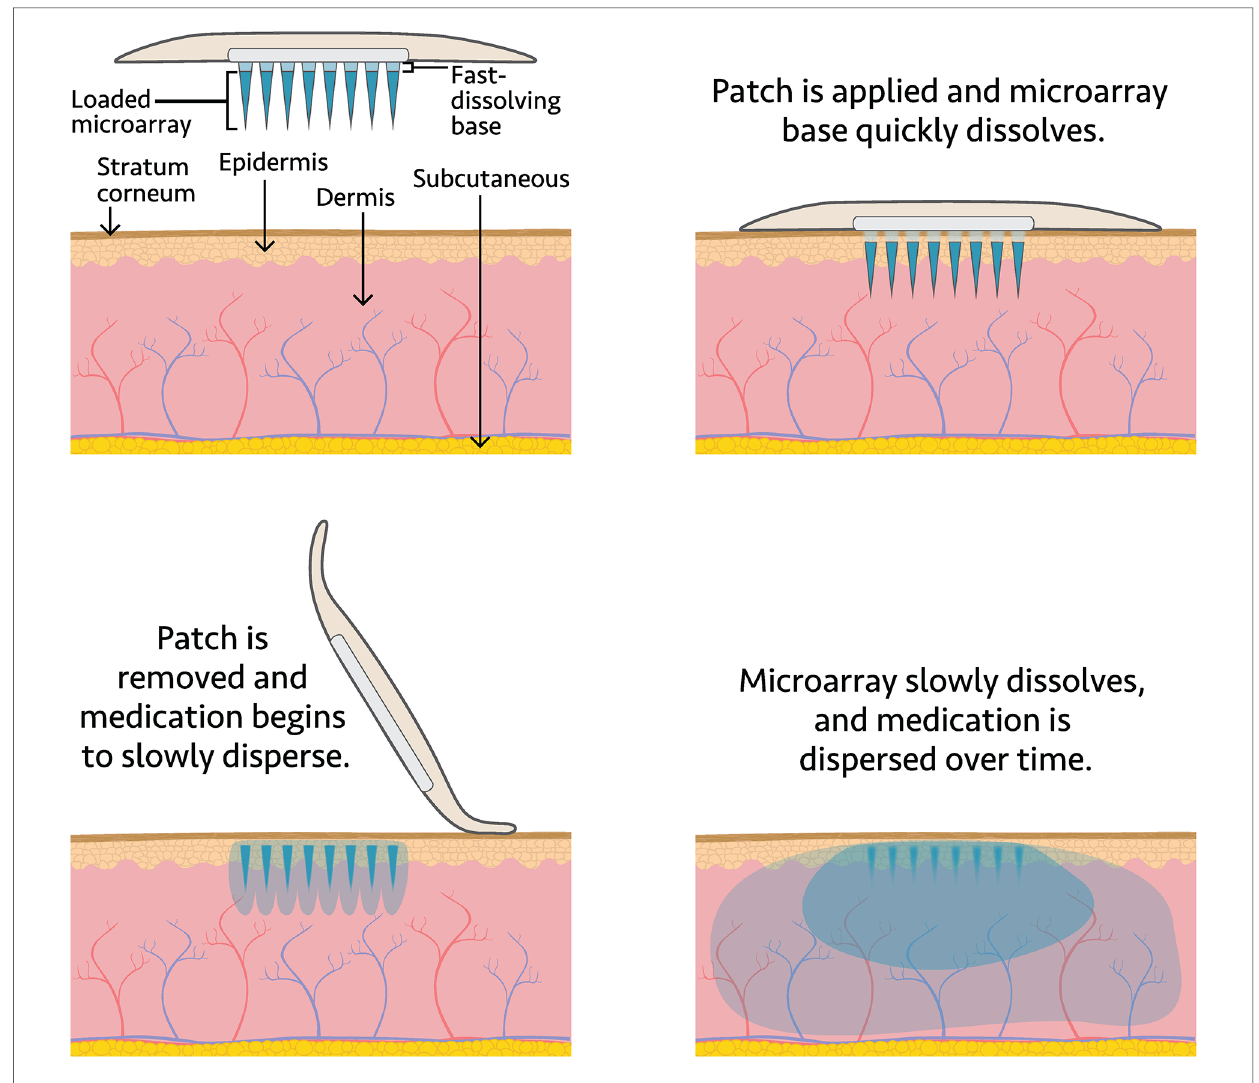
FIGURE 1 Dissolving MAP drug delivery system.